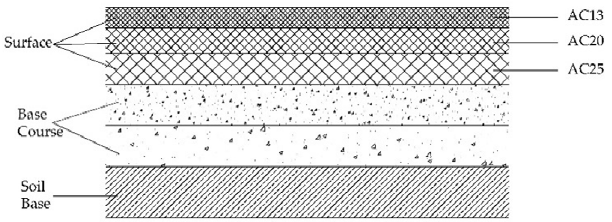
Figure 4. Schematic diagram of pavement structure.